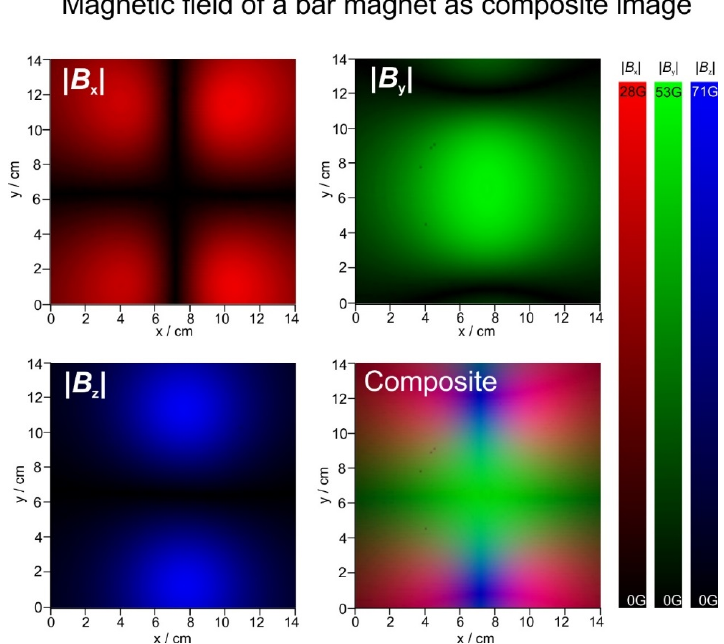
Figure 8. Magnetic field of a bar magnet in x , y and z direction in absolute values. The x , y and z images are added to form the final composite RGB representation of the magnetic field.